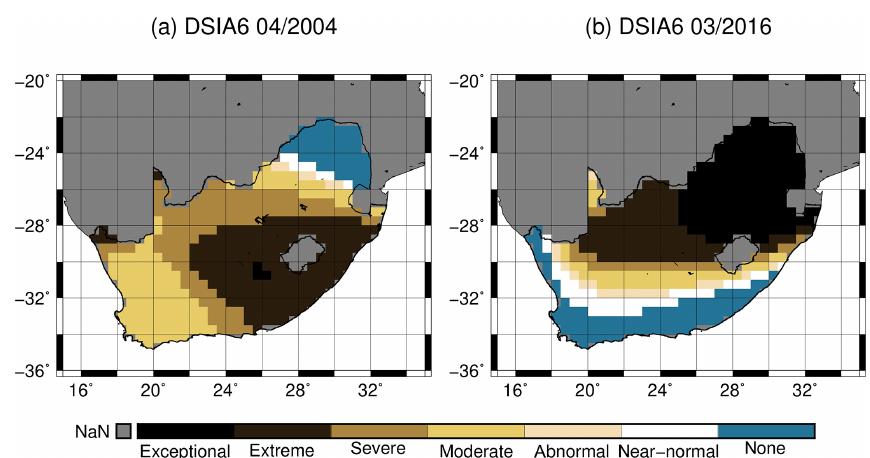
Figure 12. DSIA6 (–) for real GRACE-TWSC data within South Africa (black line; GADM, 2018) for (a) April 2004 and (b) March 2016.